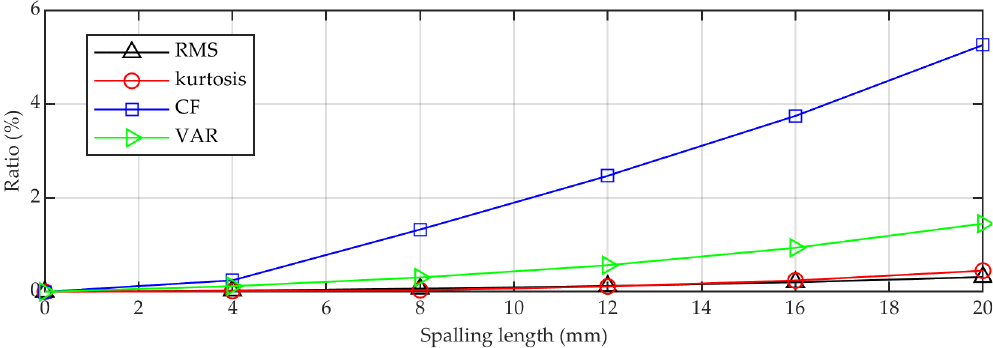
Figure 10. The variations of the RMS, kurtosis, CF, and VAR of the first gearbox housing longitudinal vibration at different spalling lengths.